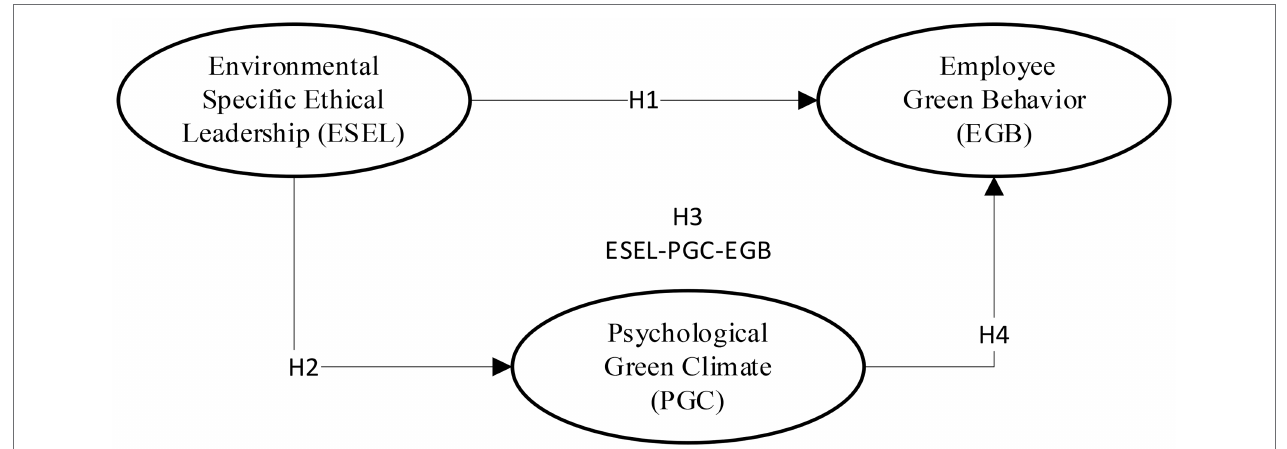
FIGURE 3 | Research